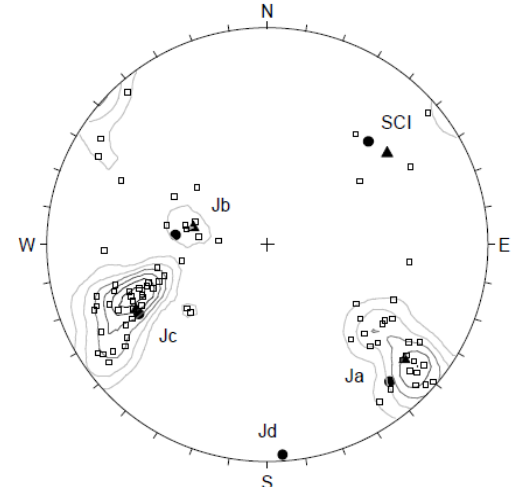
Figure 7. Stereographic projection representing the comparison between the TLS (triangles) and the compass poles (circles) (from Rotonda, T. et al. 2007)